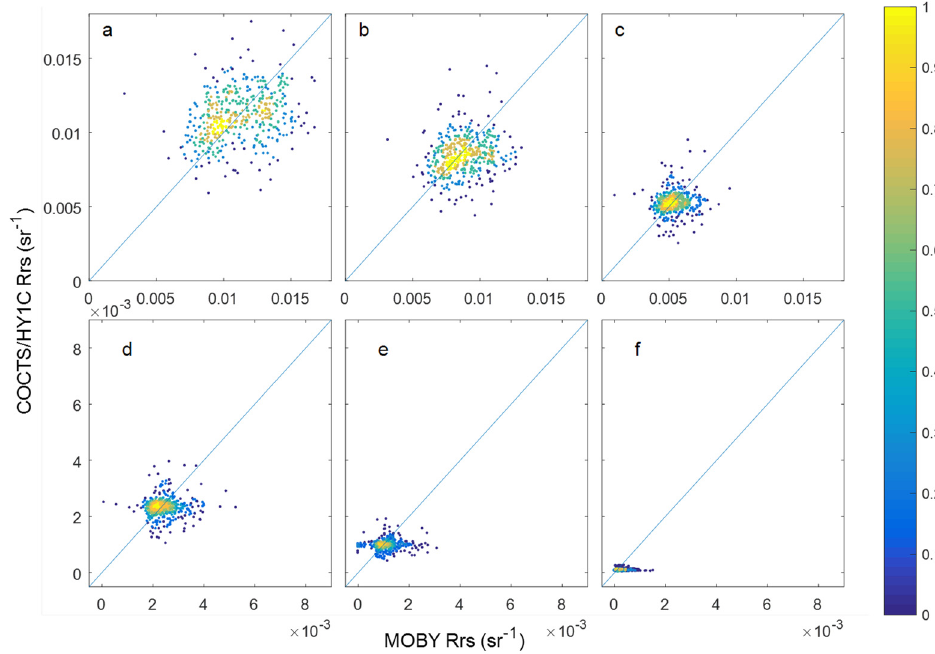
Figure 2. The comparison of R rs matchups between COCTS/HY-1C and MOBY measurements on the same day, with the density of dots indicated by different colors. Subfigures ( a – f ) represent the values at Bands 1–6. Table 2. Comparison of the R rs between the COCTS/HY-1C and MOBY